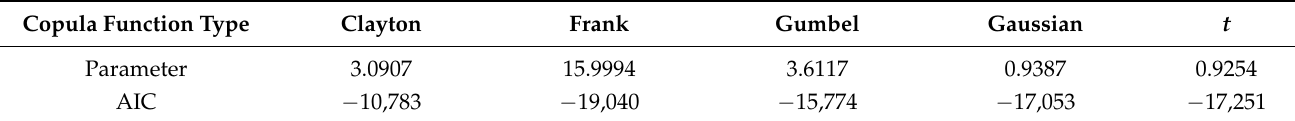
Table 3. Parameters and AIC values of different copula functions for Machine pair 7–8.